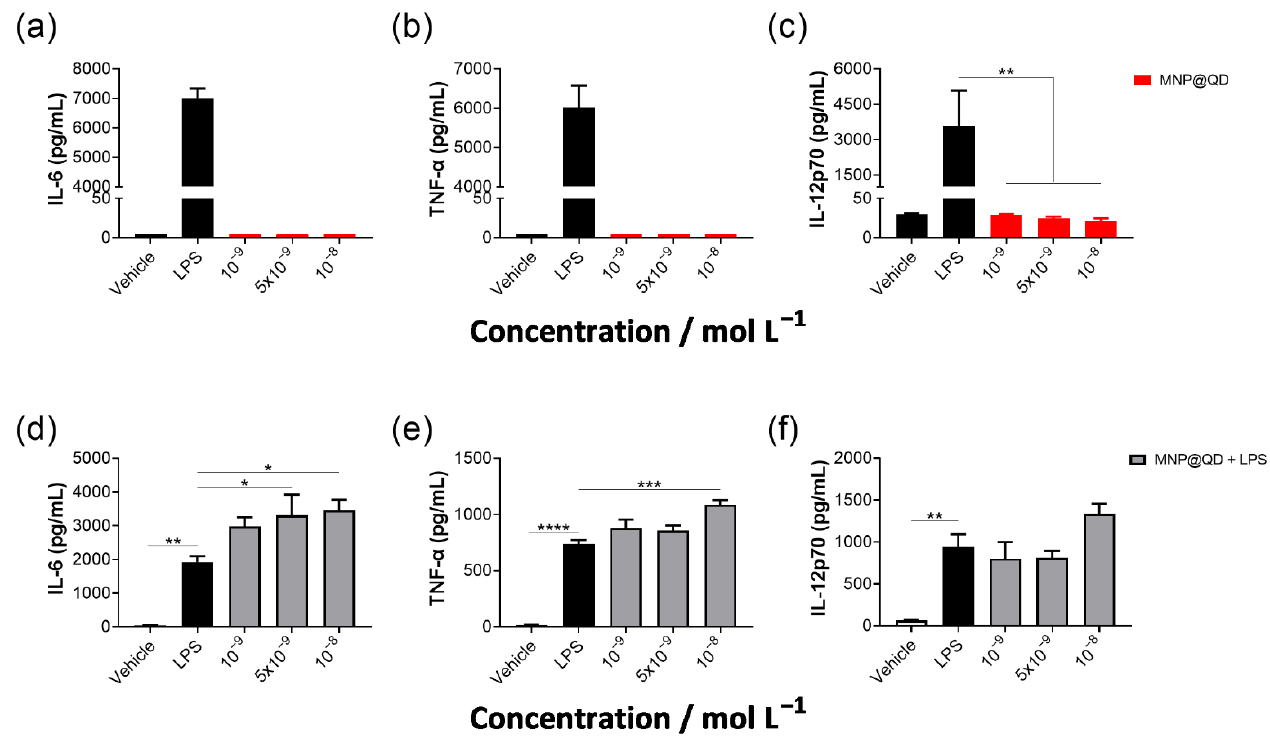
Figure 5. Cytokine production by BMDCs treated with the MNP@QD. IL-6, TNF- α , and IL-12p70 secretion after 24 h-treatment with the MNP@QD alone ( a – c ) or after a 24 h-treatment with the MNP@QD plus 24 h LPS treatment ( d – f ). Cytokine production was evaluated in culture supernatants by ELISA. Each bar represents the average of four replicates. Error bars represent SEM. Graphs are representative of three independent experiments. * p < 0.05; ** p < 0.01; *** p < 0.001; **** p < 0.0001. Statistical significance was obtained with One-way ANOVA with Sidak’s multiple comparisons test.